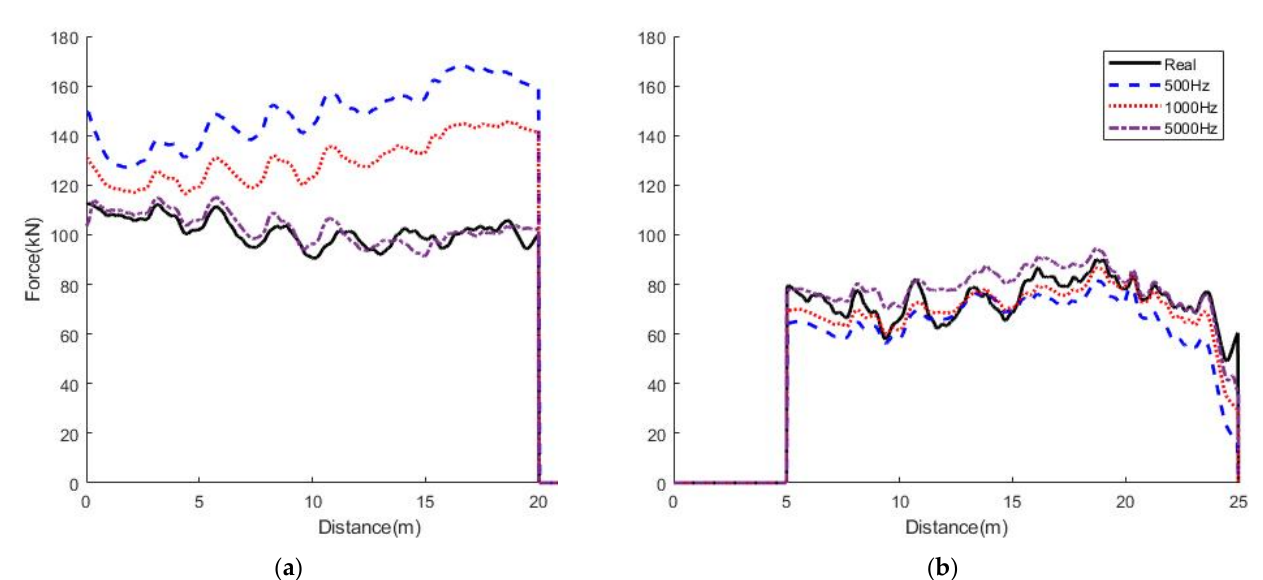
Figure 4. Influence of sampling rate on the accuracy of A-MFI results: ( a ) first axle; and ( b ) second axle.